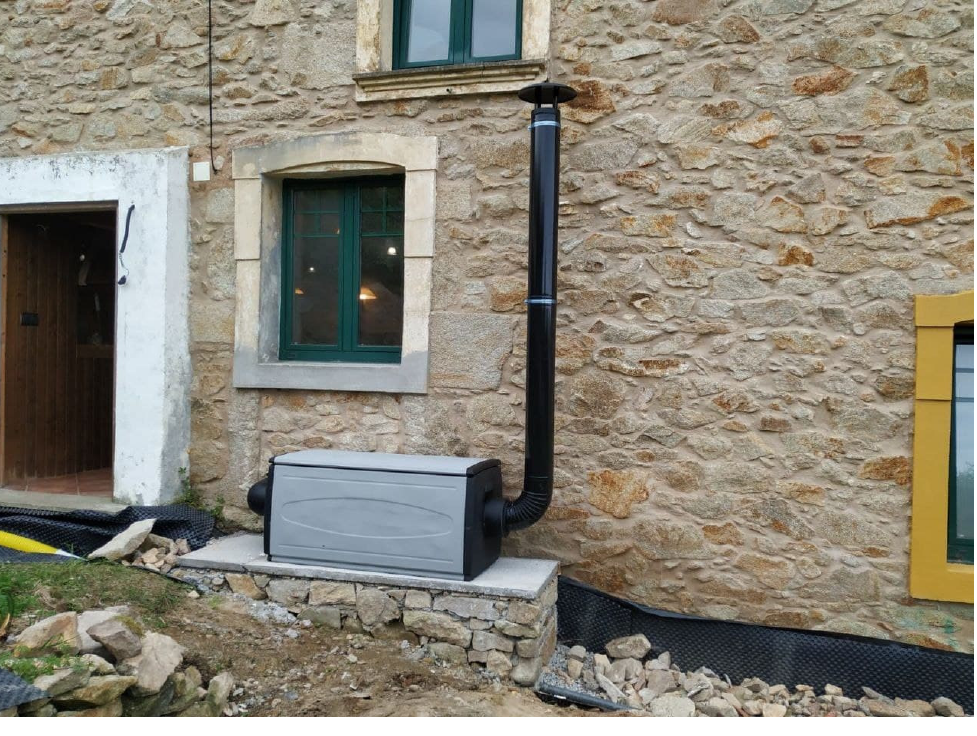
Atmosphere 2022 , 13 , x FOR PEER REVIEW Figure 3. Mitigating device. Source: photo by author. Figure 3. Mitigating device. Source: photo by author.